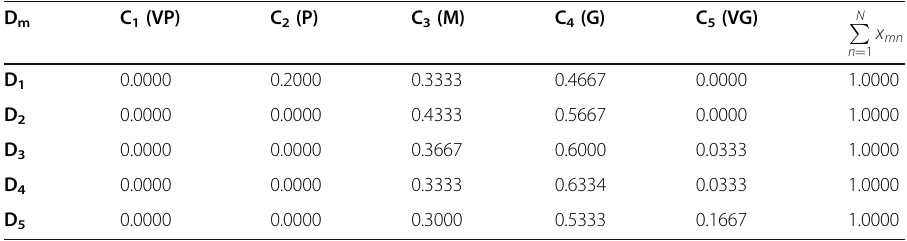
Table 4 The normalized decision matrix